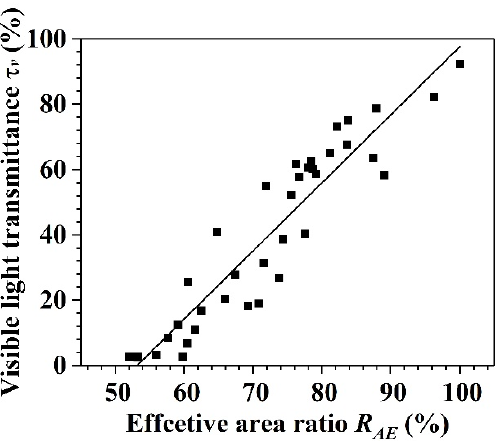
Figure 11. Relationship between visible light transmittance τ v and effective area ratio R AE .